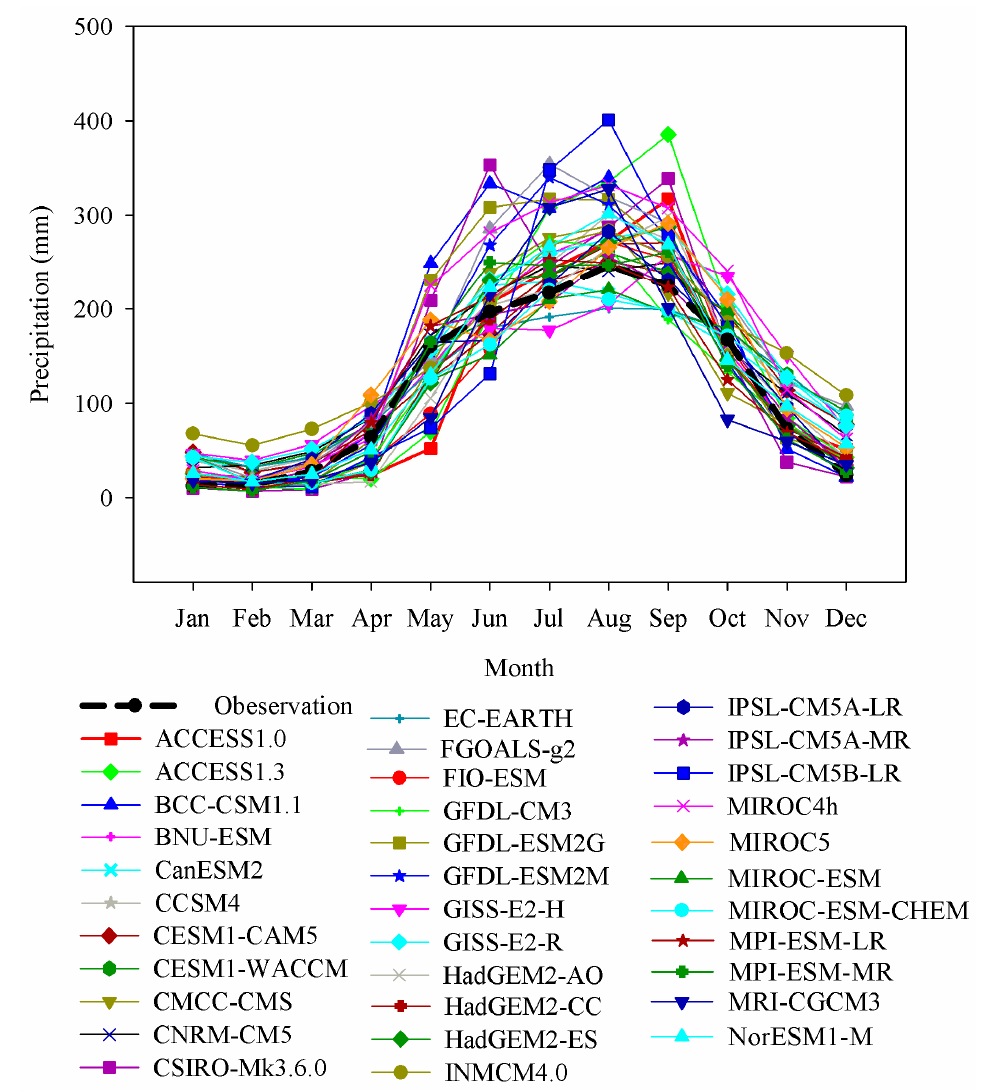
Figure 3. Variations in observed precipitation and general circulation model (GCM) simulations in the mean annual cycle during the period 1975–2004 over the LMB. mean annual cycle during the period 1975–2004 over the